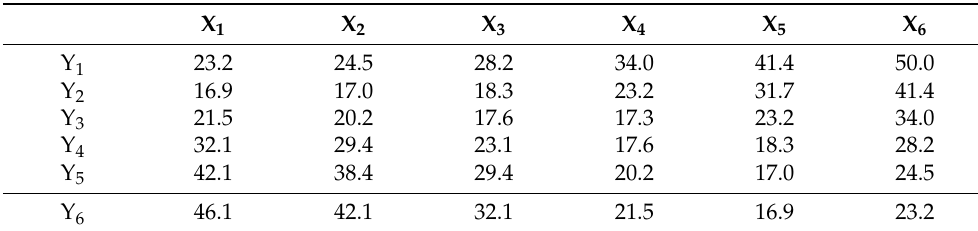
Table 3. Moving values of rods of double-sided curve.